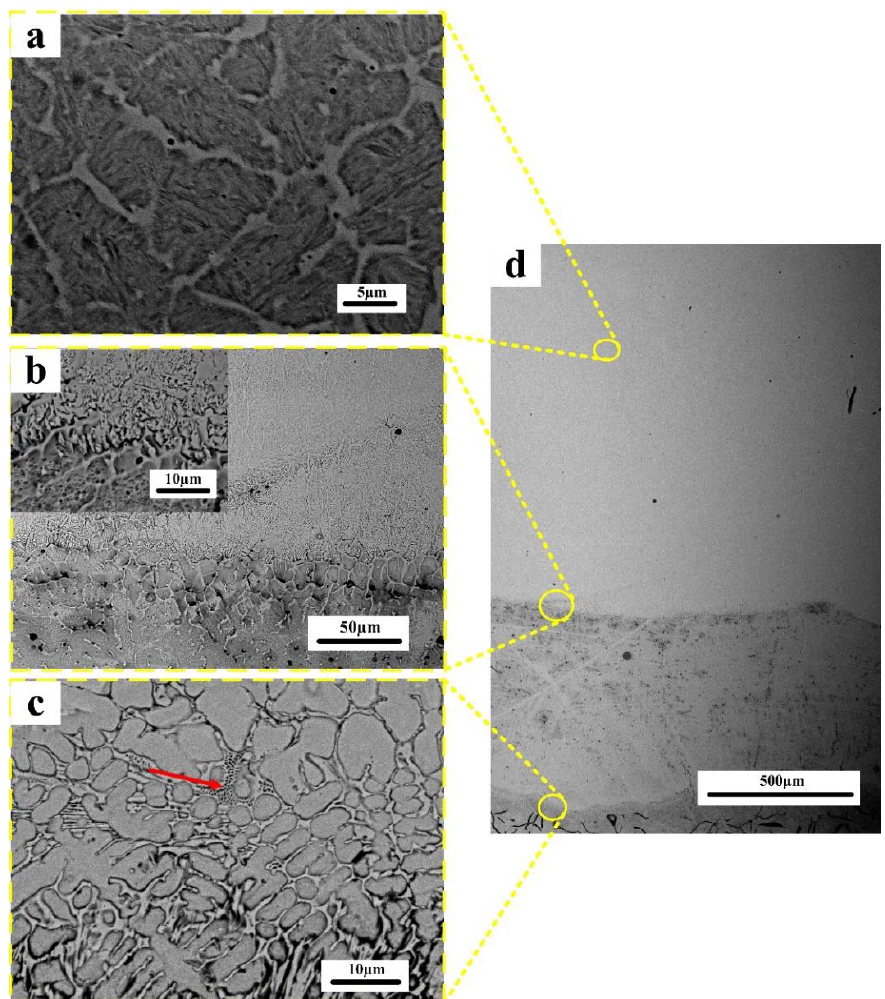
Figure 3. Cross-section of the F55 + AISI415 coating on GCI: ( a ) outer layer; ( b ) outer layer–buffer layer interface; ( c ) buffer layer–GCI interface (melted zone), arrow indicates a typical ledeburitic microstructure; ( d ) complete cross-section of the coated GCI, with buffer layer and disc.